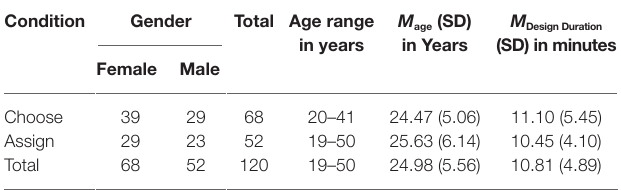
TABLE 1 | Participant and study